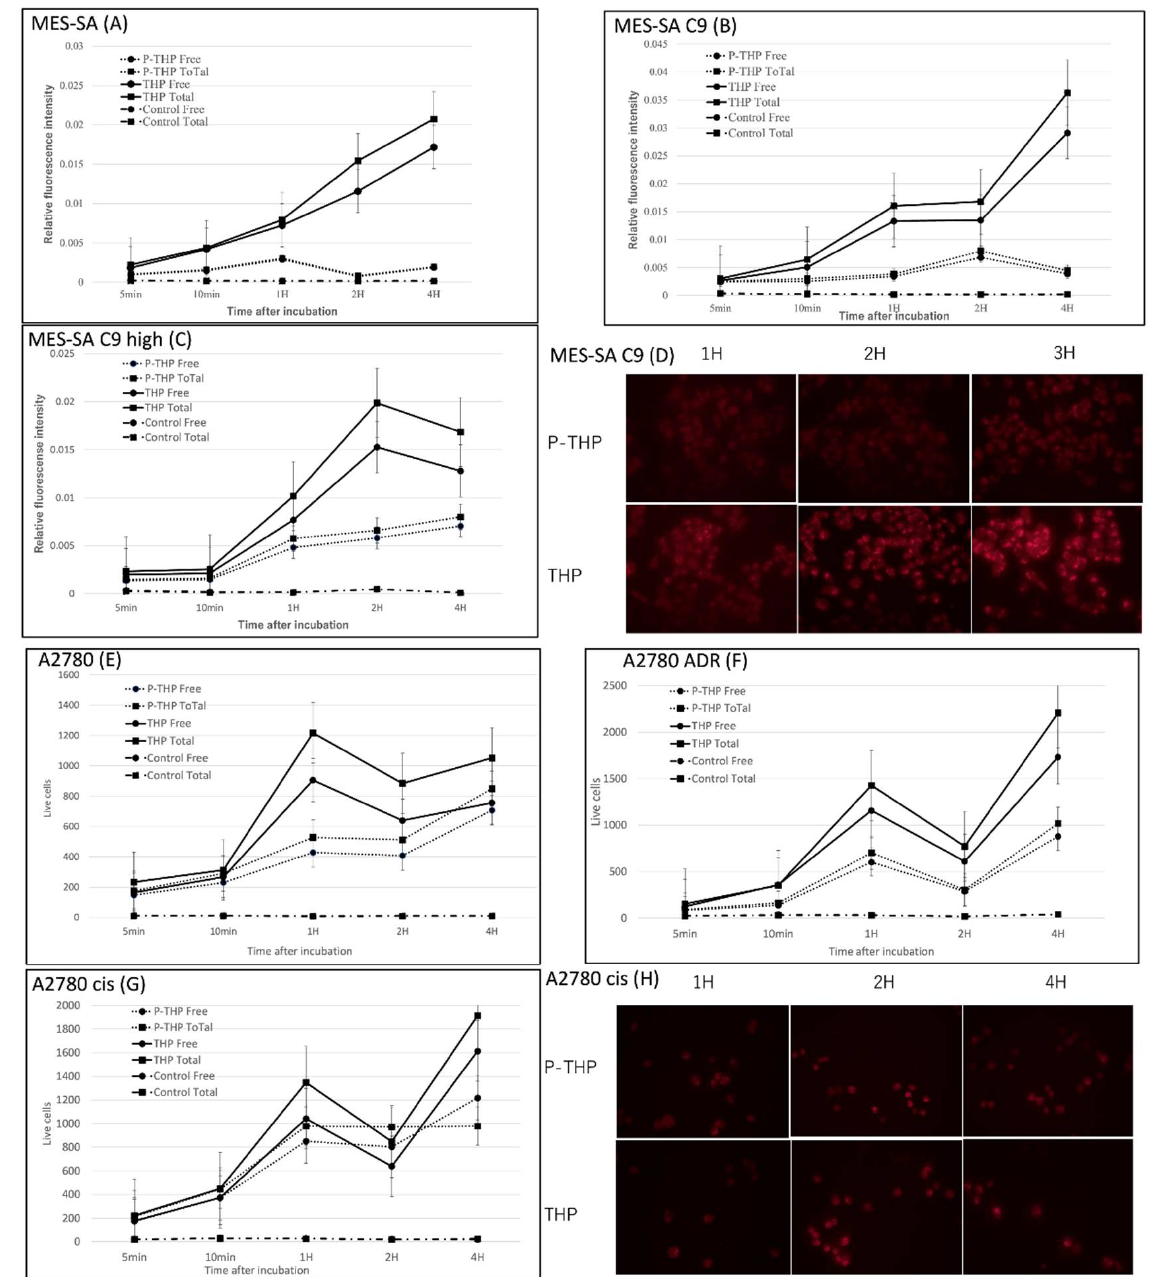
Figure 2. Intracellular uptake of THP and PTHP for MES-SA ( A ), MEA-SA C9 ( B ), MEA-SA C9 high ( C ), A2780 ( E ), A2780/ADR ( F ), A2780cis ( G ). The fluorescence imaging of MES-SA C9 ( D ) and A2780 cis ( H ) were also shown. ‘Free’ means released THP and ‘Total’ means total THP. Data are expressed as a mean percentage of control growth ± Standard Deviation